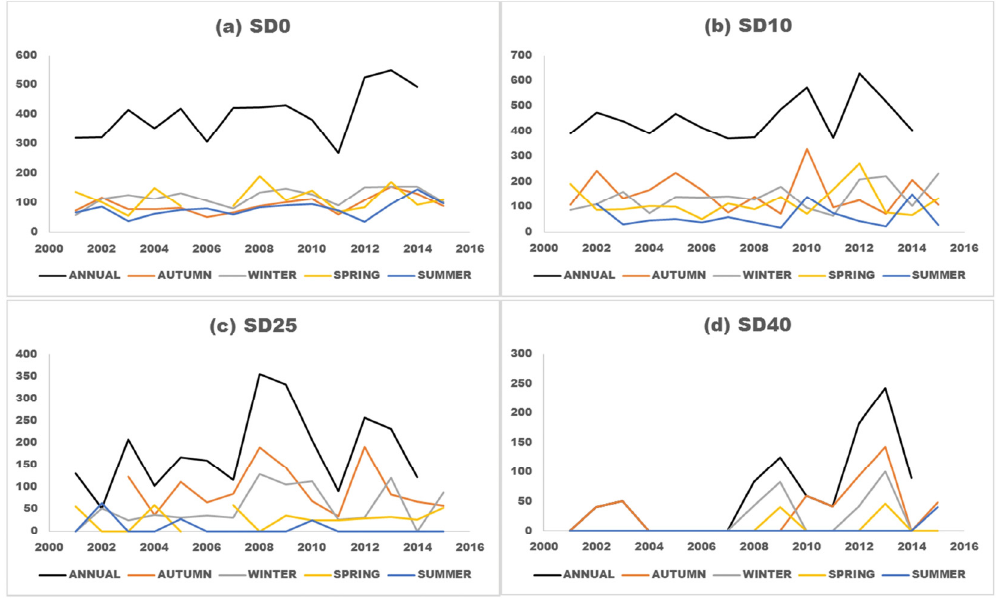
Figure 8. Annual and seasonal time series of SD0 ( a ); SD10 ( b ); SD25 ( c ) and SD40 ( d ). Table 4. Values of Z statistic and trend magnitudes of annual and seasonal observables. The Z values > 1.96 are reported in bold.